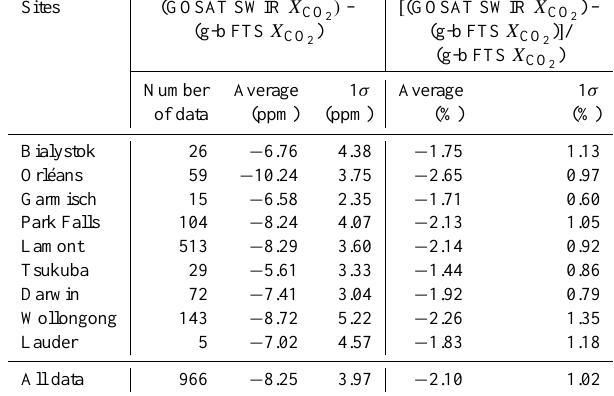
and g-b FTS X CO for 2 2 (given 2